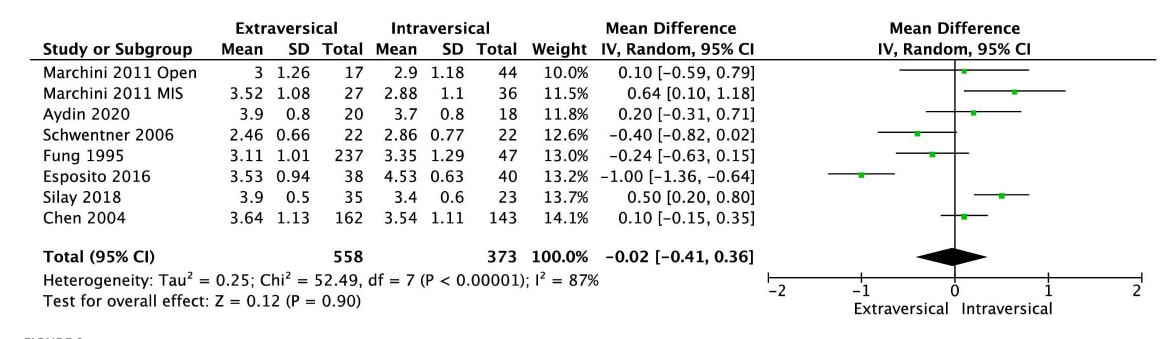
FIGURE2 Forest plot of preoperative VUR grade in EVUR vs. IVUR group.